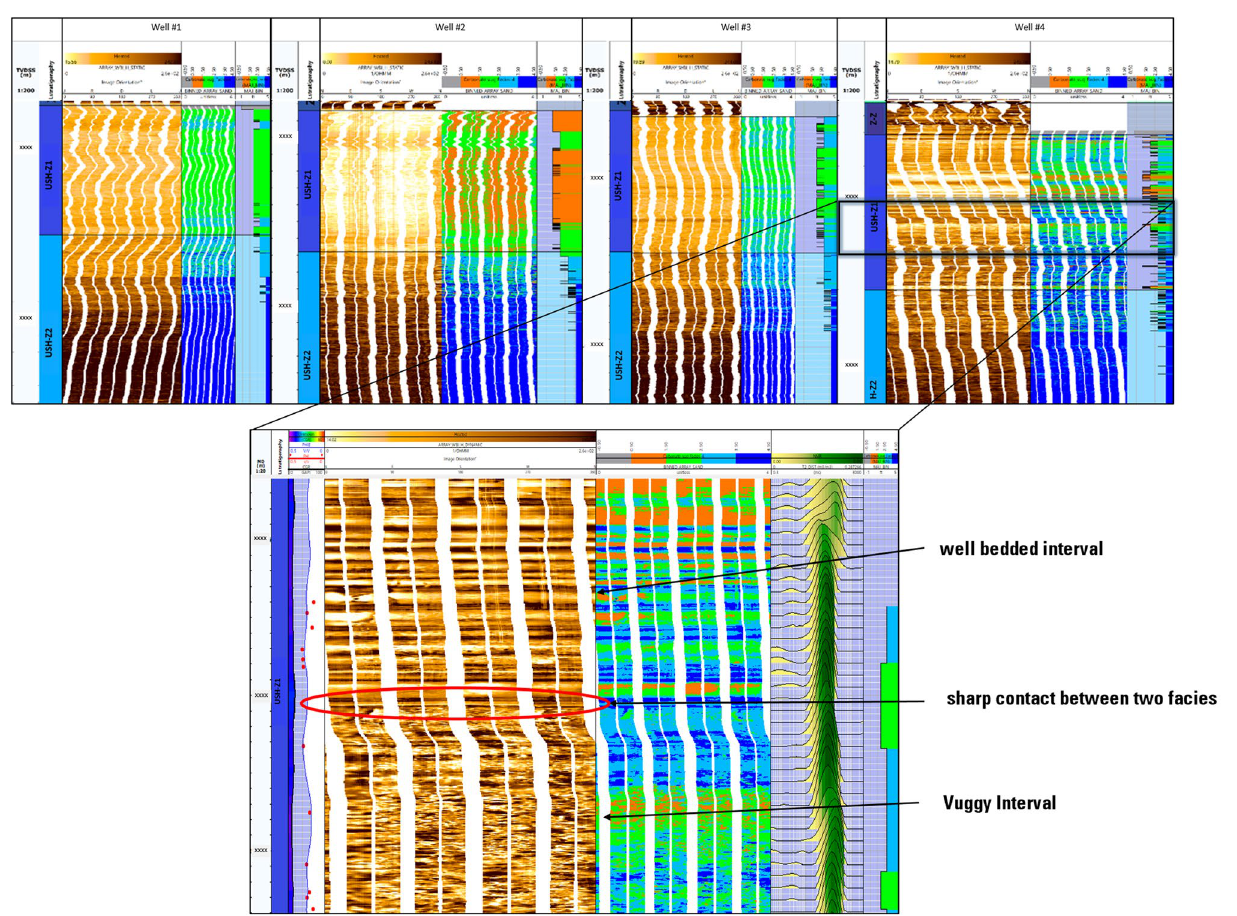
Fig. 11 Laterally heterogeneity in Upper Shuaiba Formation in well #4. Although there is no textural change in the Upper Shuaiba Formation in wells 1 to 3, the Well #4 indicates an obvious textural change in Upper Shuaiba